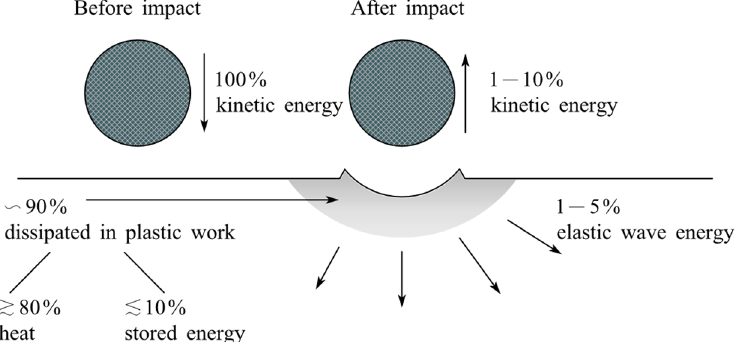
Figure 33. The energy balance before and after the normal impact of a spherical erosive particle [248].